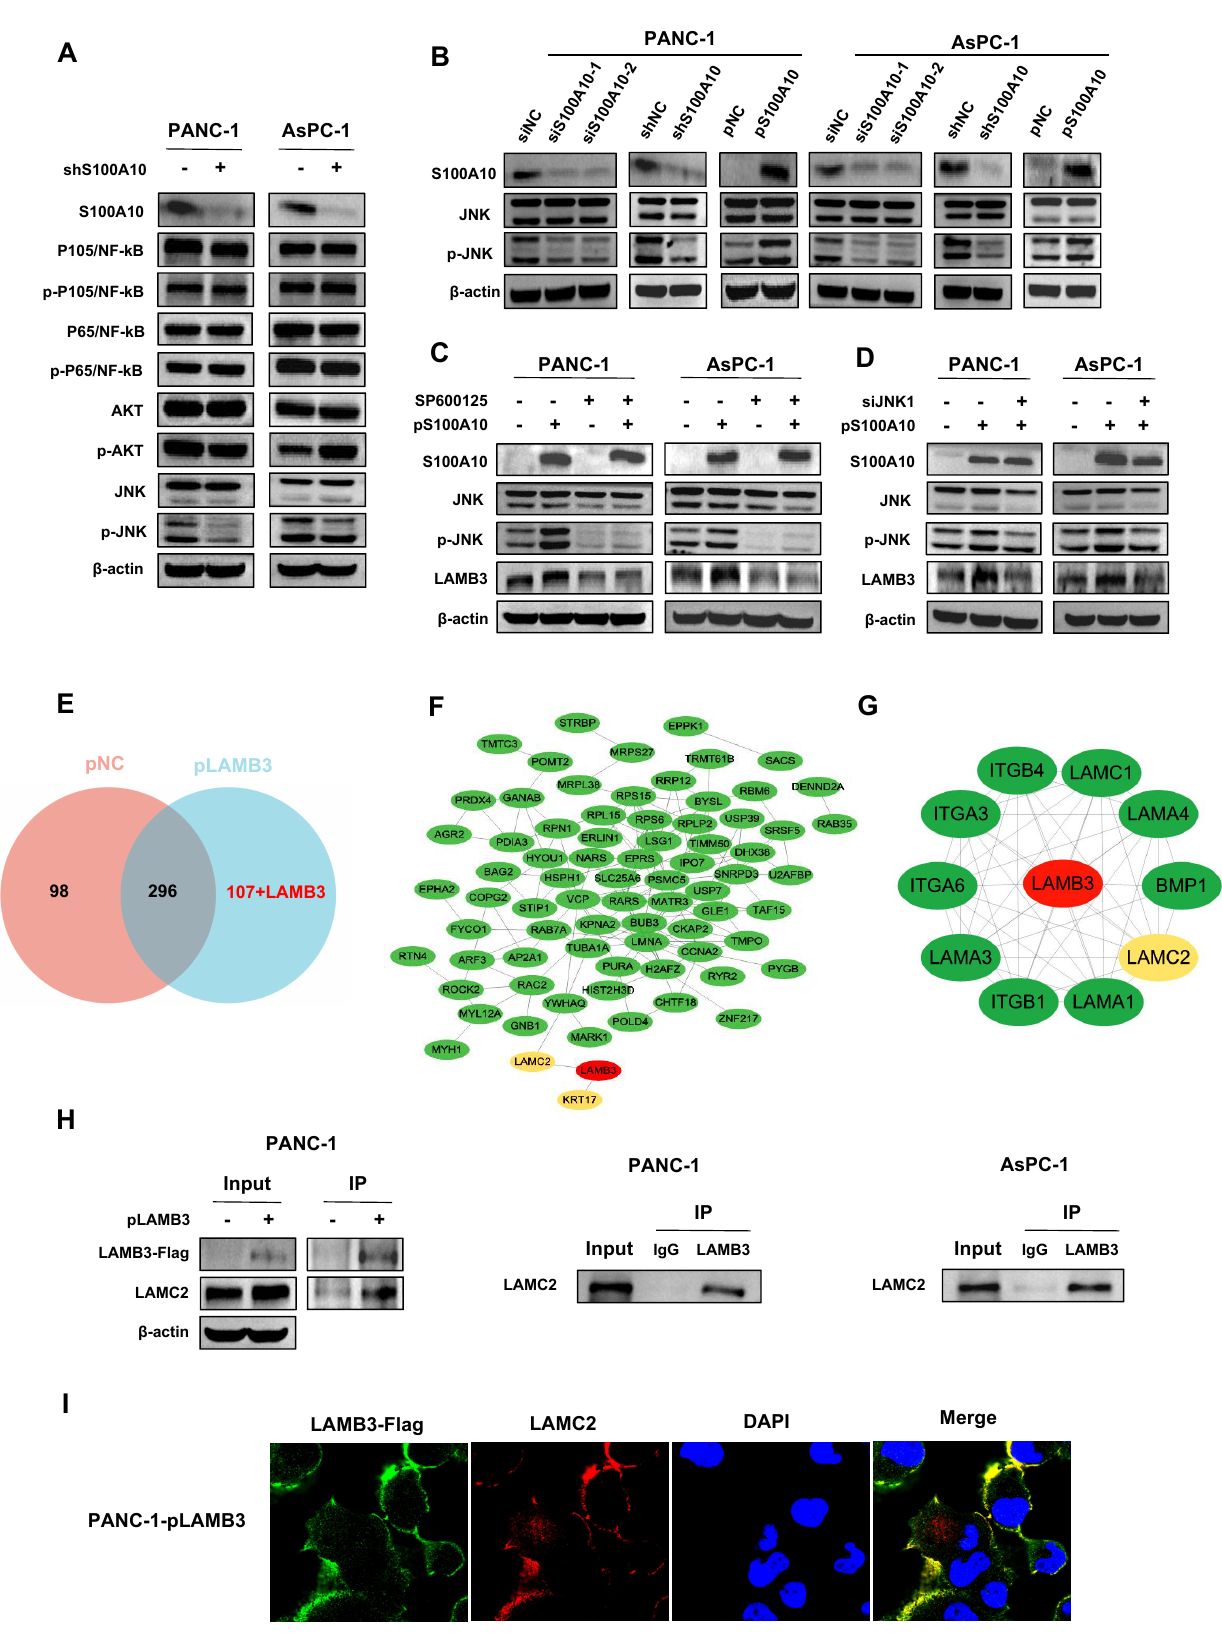
Figure 8. S100A10 activates LAMB3 through JNK pathway and LAMB3 further interacts with LAMC2 in PDAC cell lines. ( A ) Western blotting was used to measure the expression of indicated proteins